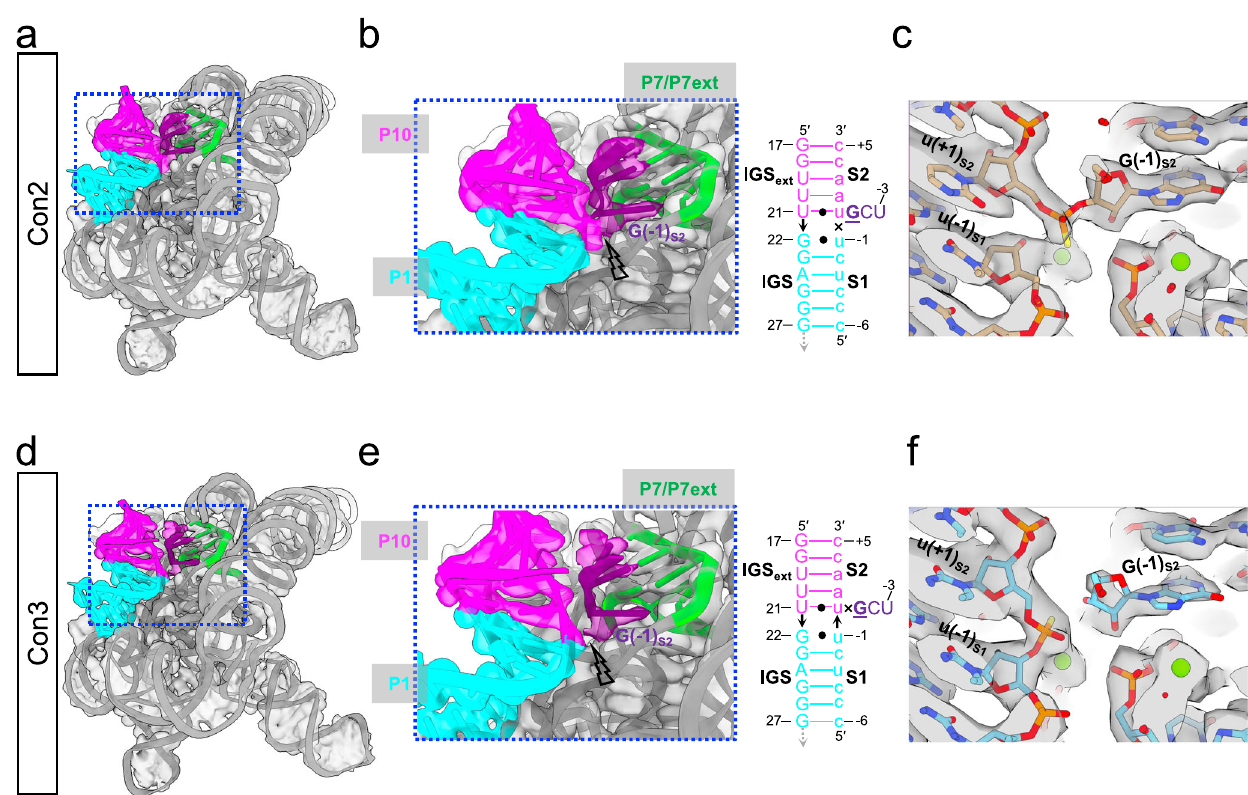
Fig. 3 | Structural features of Tetrahymena ribozyme in Con2 and Con3. a , d Cryo-EMmapandmodelofCon2( a )andCon3( d ). b , e Zoom-inviewsofP1and P10 helices of Con2 ( b ) and Con3 ( e ). Their secondary structures are shown, with